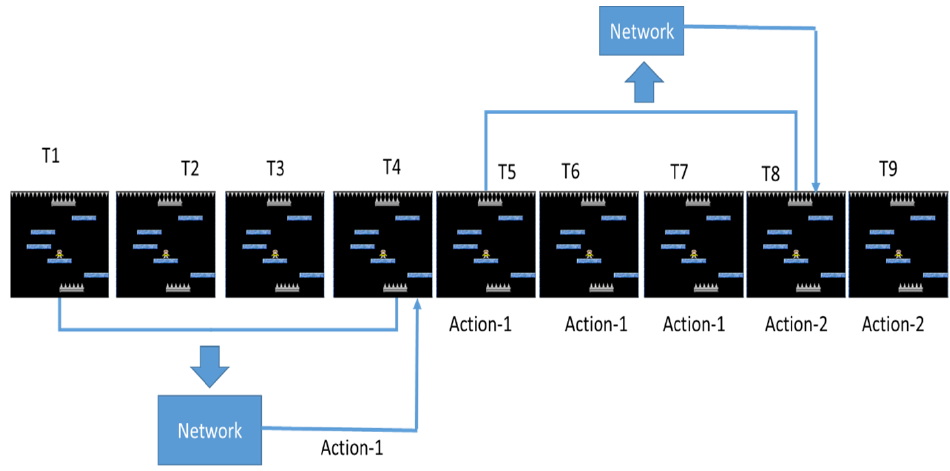
Figure 10. The case without frame skipping.